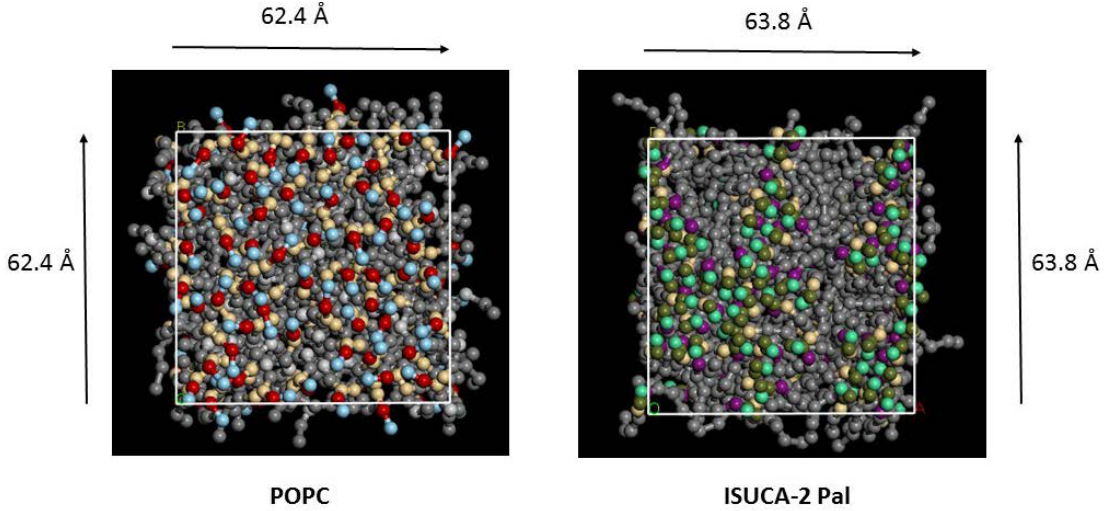
Figure 1. Top view of pure POPC and ISUCA-2 Pal lipid bilayers. Grey balls represent hydrocarbon tails.